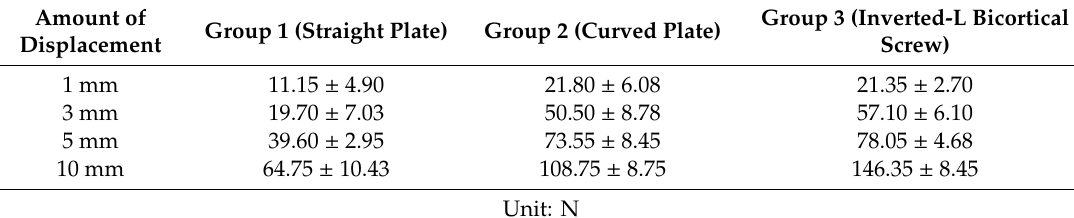
Table 2. Resistance force of the three groups (median ± interquartile range